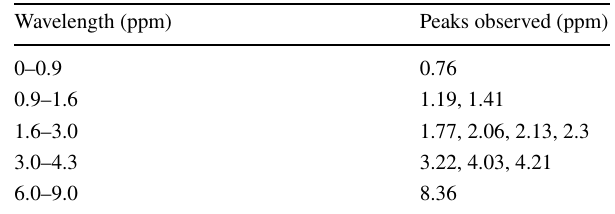
Table 4 H 1 -NMR peak description of aquatic fulvic acid of